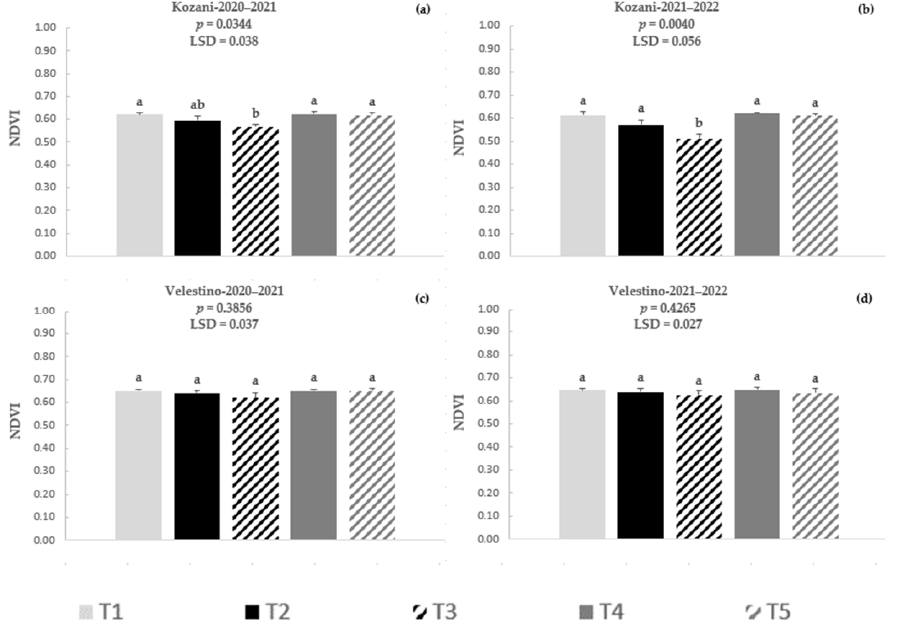
Figure 4. Crop NDVI in ( a ) Kozani-2020–2021, ( b ) Kozani-2021–2022, ( c ) Velestino-2020–2021, and ( d ) Velestino-2021–2022. Treatment DF: 4; Error DF = 15; Total DF = 19; DF: Degrees of Freedom. At each site-year, different lowercase letters indicate significant differences between treatment means according to Fisher’s LSD test ( a = 0.05). Vertical bars indicate standard errors. At the end of the 2020 ‐ 2021 growing season in Kozani, grain yield was 30, 38, and 40% higher in plots treated with pyroxsulam + florasulam (T4) than in plots treated with 2,4 ‐ D at 300 g a.e. ha − 1 (T2), untreated plots (T1), and plots treated with 2,4 ‐ D at a rate of